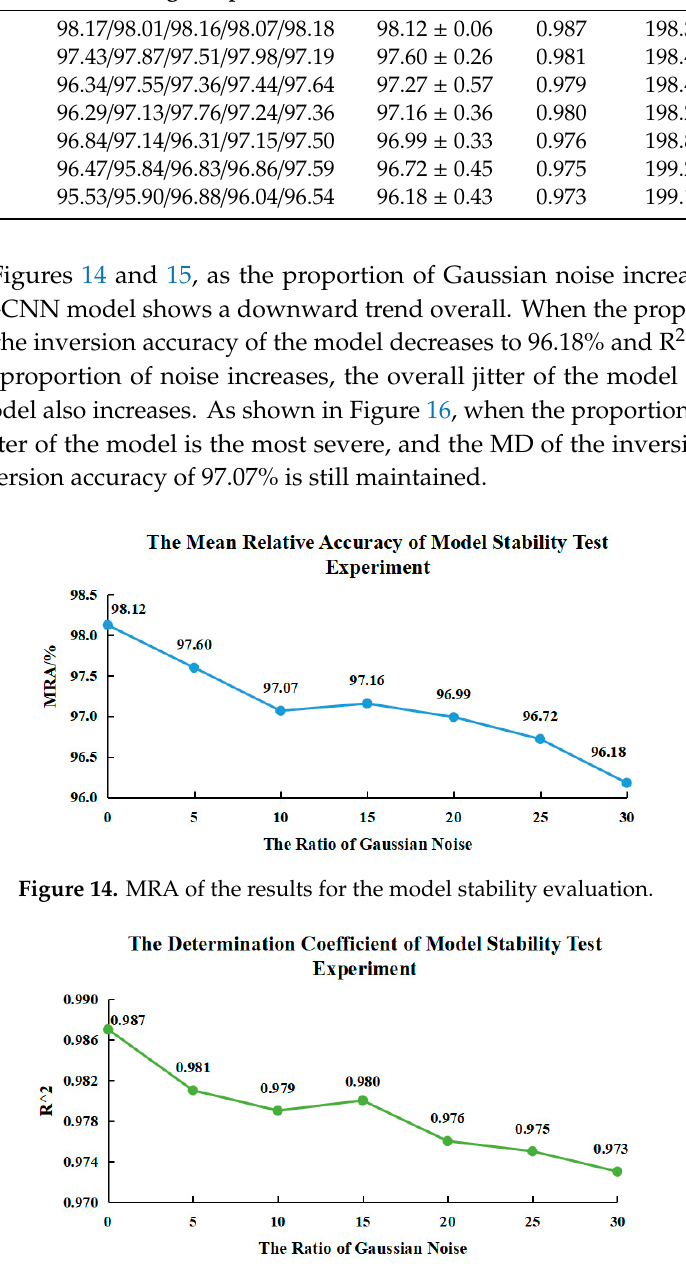
Table 8. Model stability test experiment inversion results.